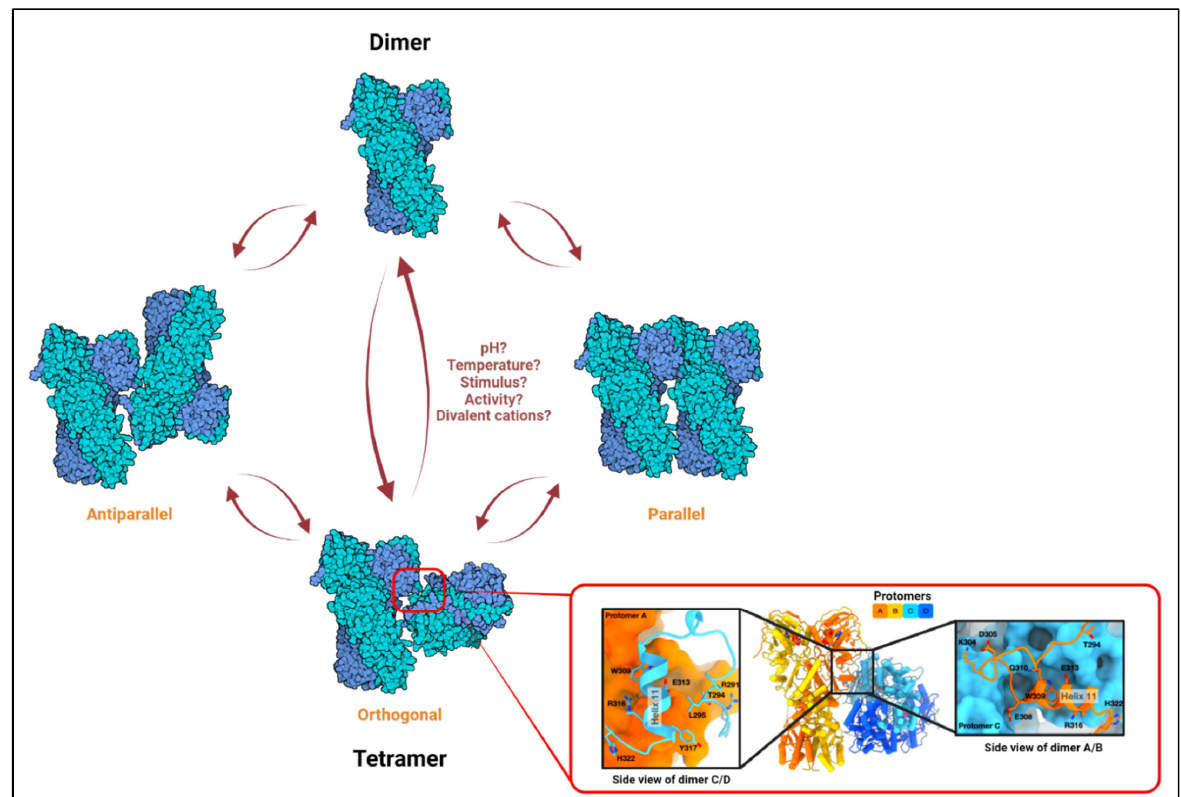
Figure 1. The TRAP1 tetramer. Based on in vitro studies on HSP90 oligomerization, rapid alterations in temperature, chaperone activity, or local concentration of divalent cations, which are common occurrences in the mitochondria, may influence dimer–tetramer transition. Three distinct confor- mations have been observed for the TRAP1 tetramer in vitro: orthogonal, parallel, and antiparallel [22,73]. The conditions required for the adoption of or transition to a particular configuration are only predicted and remain unclear. A high-resolution MD-MD dimer–dimer interface has only been shown for the orthogonal structure (shown in the inset; adapted from Liu et. al., Biorxiv., 2020 [73]). Left and right sub-insets show interacting residues from protomer C (blue) to A (orange) and from A to C at the dimer–dimer interface, respectively.